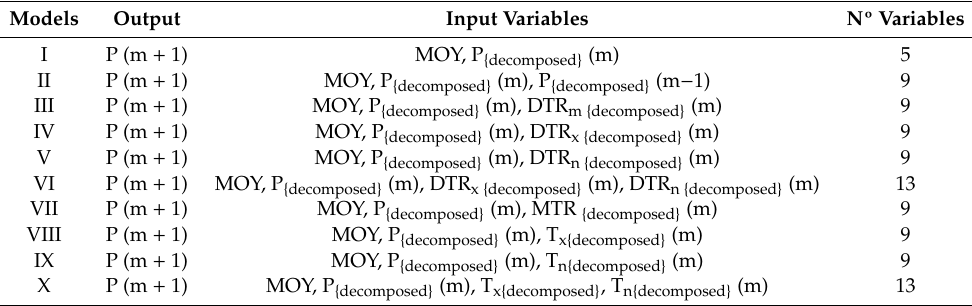
Table 3. Inputs and number of variables of each of the wavelet neural network models (WNN) models evaluated in this work (m = month; MOY = month of year; P = precipitation; DTR m = mean diurnal temperature range; DTR x = maximum diurnal temperature range; DTR n = minimum diurnal temperature range; MTR = monthly temperature range; T x = maximum temperature; T n = minimum temperature).